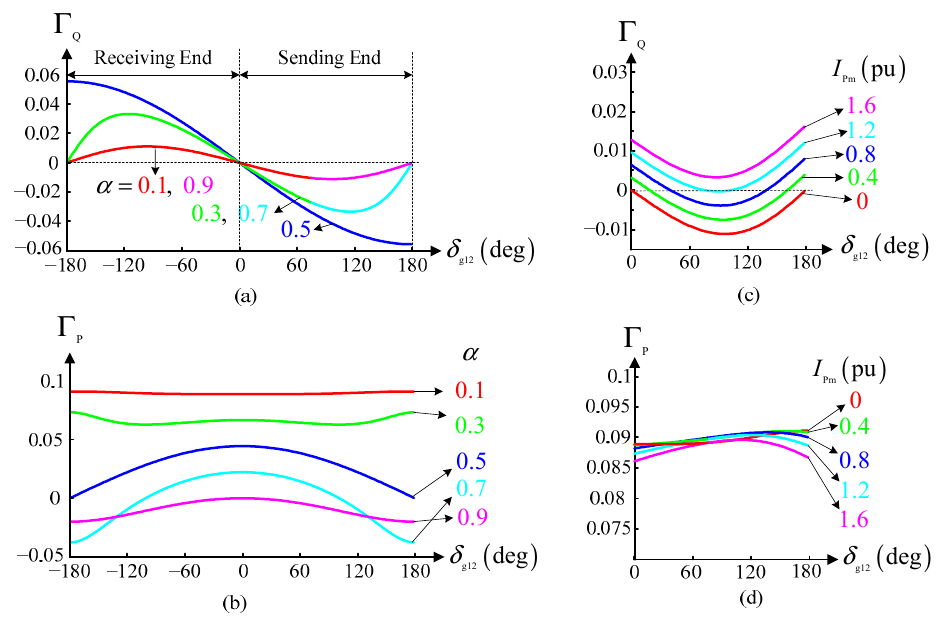
Figure 5. Curves of Γ Q and Γ P with different parameter values. The default parameter values are γ = ∞ , α = β = 0.1, I Pm = I Qm = 0, X = E g = 1, and H = 50. ( a ) Curves of Γ Q with different wind farm locations; ( b ) Curves of Γ P with different wind farm locations; ( c ) Curves of Γ Q with different levels of wind turbine injecting active current; ( d ) Curves of Γ P with different levels of wind turbine injecting active current.